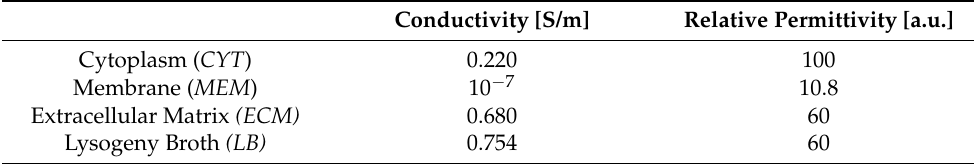
Table 1. Electrical properties of the parameters used in the MMT